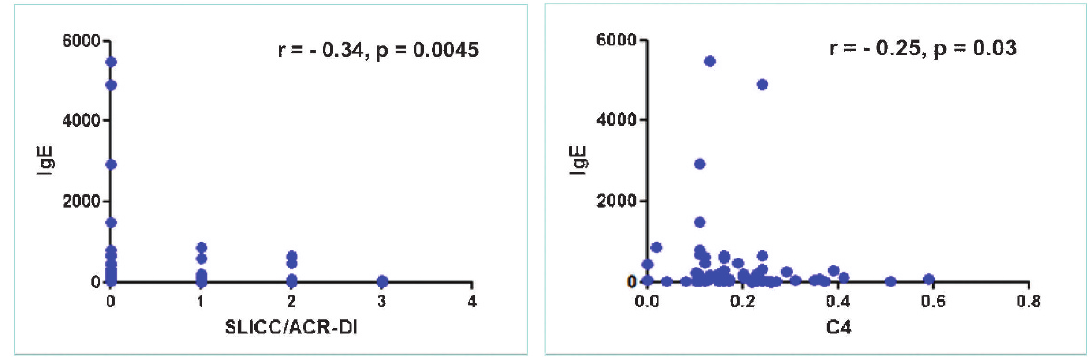
Figure 2 - Correlations between IgE serum concentrations, C4 levels and SLICC/ACR-DI score in patients with juvenile systemic lupus